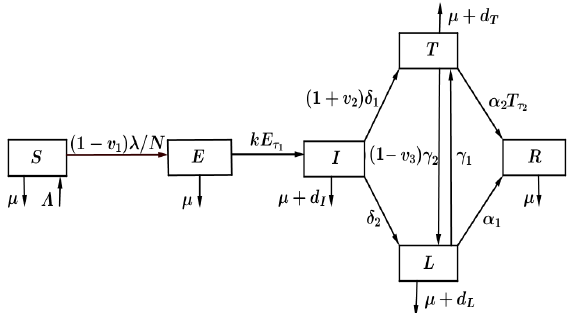
Figure 1. Transfer